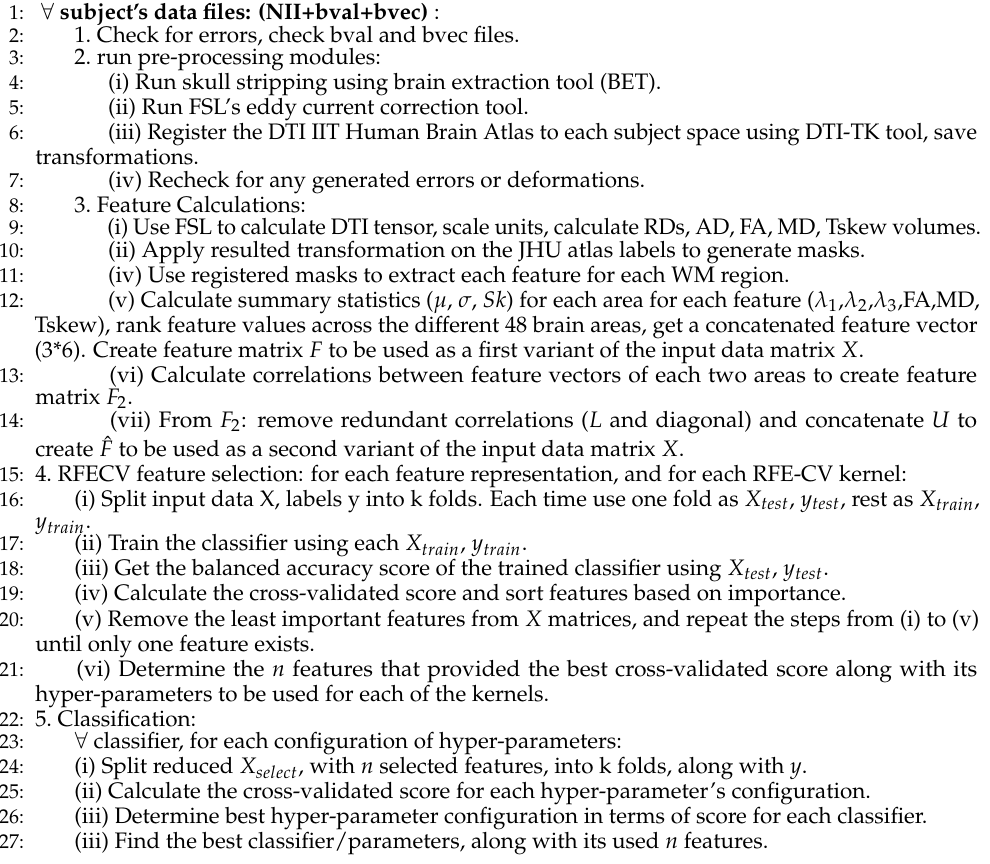
Algorithm 1 Diffusion tensor autism diagnosis